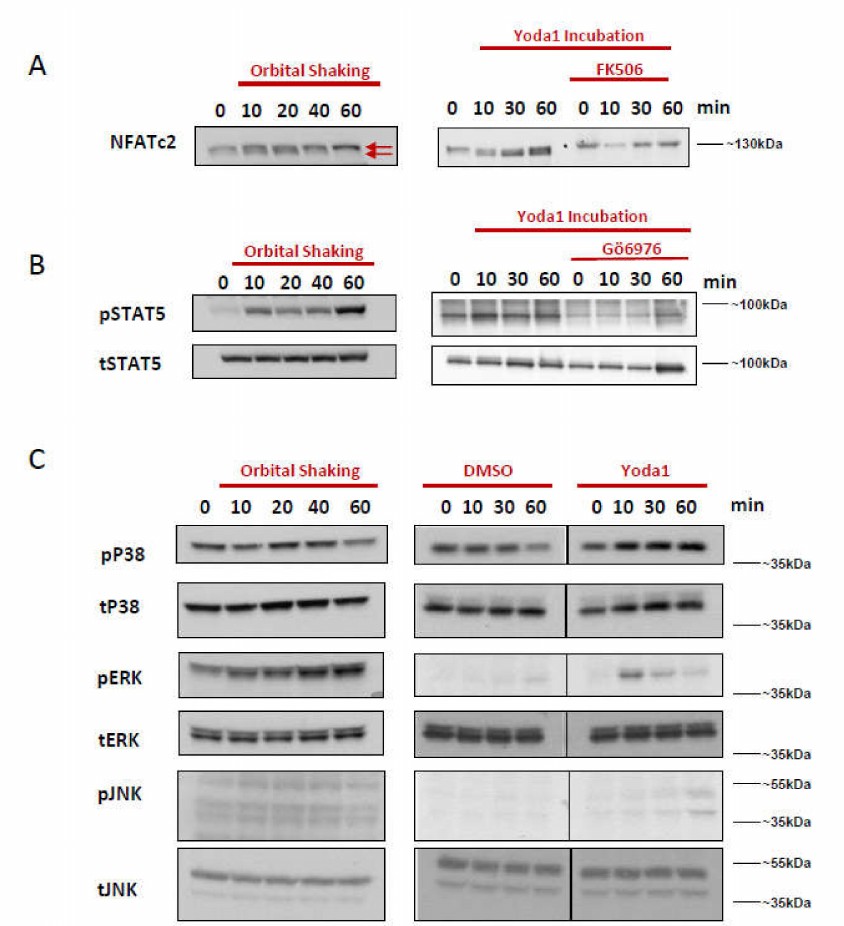
Figure 2. Mechanical stimulation and Yoda1 incubation induces Ca 2+ -dependent signaling pathways. Erythroblasts were either cultured on an orbital shaker set at 300 RPM and sampled at 0, 10, 20, 40, and 60 min, or stimulated with 1 µ M Yoda1 with or without specific inhibitors and sampled at 0, 10, 30, 60 min. Total protein lysates were subjected to SDS-polyacrylamide gel electrophoresis and western blotting. ( A ) Some of the erythroblasts were pretreated with 1 µ M FK506 before Yoda1 incubation. Blots were stained with antibodies against NFATc2 (arrows indicate the slower migrating phosphorylated, and faster migrating unphosphorylated isoforms). ( B ) Some of the erythroblasts were pretreated with 500 nM Gö6976 before Yoda1 incubation. Blots were stained with antibod- ies against tyrosine-phosphorylated-STAT5 (pSTAT5) and total STAT5 (t-STAT5). ( C ) Blots were stained with antibodies against phosphorylated JNK (Thr183/Tyr185) and total JNK, phosphorylated ERK1/2 (Thr202/Tyr204) and total ERK1/2, phosphorylated P38 (Thr180/Tyr182) and total